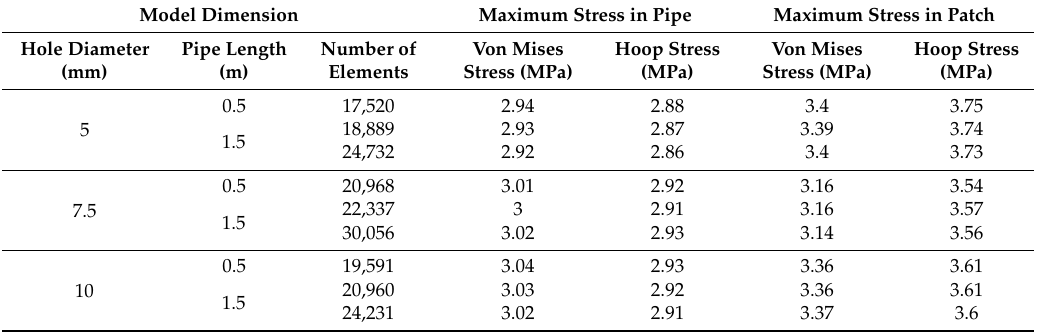
Table 4. Comparing maximum stress values in pipe and patch under internal pressure, investigating the pipe length